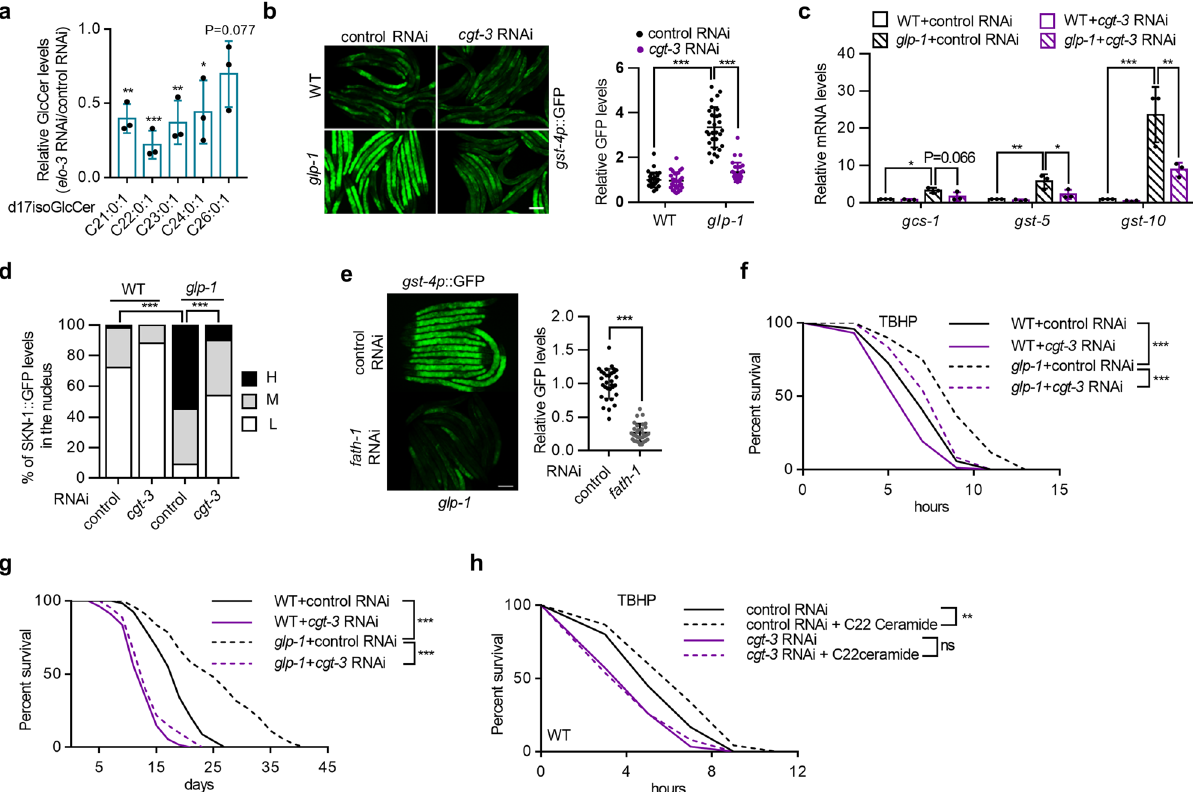
Fig. 4 C22 GlcCer regulates SKN-1 activity and longevity in response to germline loss. a Effects of elo-3 RNAi treatment on the contents of major GlcCer species. n = 3 independent experiments. b – d Effects of cgt-3 RNAi treatment on the expression of gst-4p ::GFP ( b ) ( n = 30 animals) and SKN-1 targets ( c ) ( n = 3 independent experiments), as well as SKN-1 nuclear occupancy ( d ) [ n = 99/111/79/92 animals for WT(control RNAi)/WT( cgt-3 RNAi)/ glp- 1 (control RNAi)/ glp-1 ( cgt-3 RNAi)] in wild-type and glp-1 mutant worms. ( e ) fath-1 RNAi treatment suppresses the expression of gst-4p ::GFP in glp-1 mutants. n = 32 animals. f, g Effects of cgt-3 RNAi on TBHP resistance ( f ) and longevity ( g ) in wild-type and glp-1 mutant worms. h Effects of C22 ceramide addition on TBHP resistance in control and cgt-3 RNAi-treated wild-type worms. Data are represented as mean ± SD. ∗ p < 0.05, ∗∗ p < 0.01, ∗∗∗ p < 0.001.